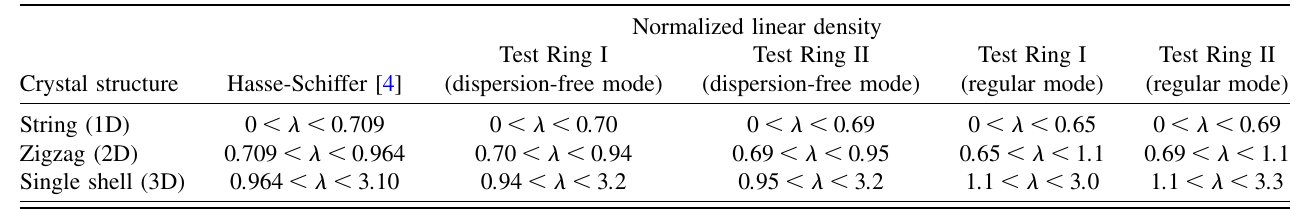
TABLE II. Normalized linear densities of structural